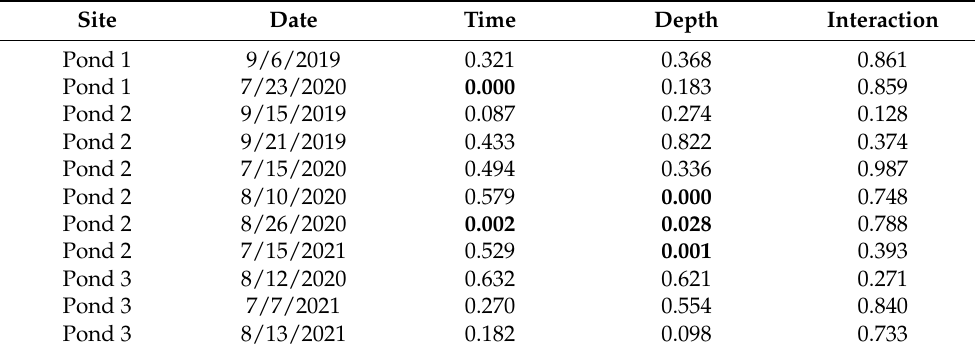
Table 1. Summary of two-way analysis of variance (ANOVA) testing with sampling depth and time of day as